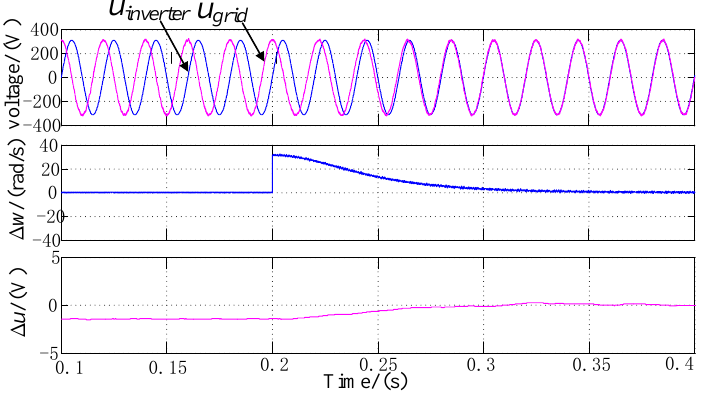
Figure 20. The dynamic synchronizing process of the renewable energy